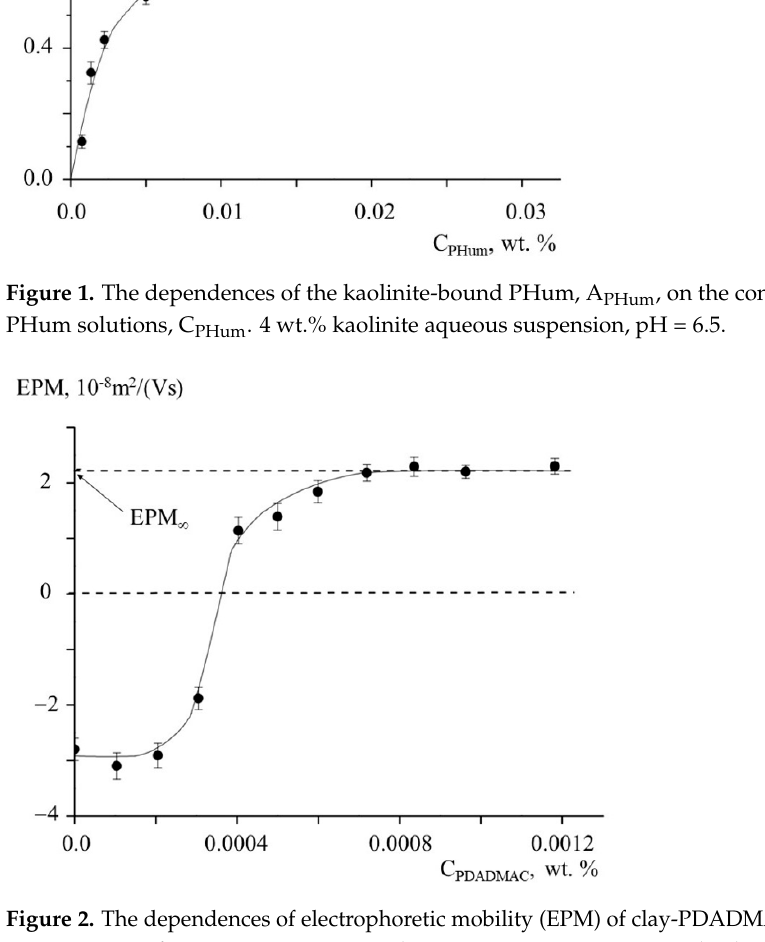
Figure 1. The dependences of the kaolinite-bound PHum, A PHum , on the concentration of aqueous PHum solutions, C PHum . 4 wt.% kaolinite aqueous suspension, pH = 6.5.